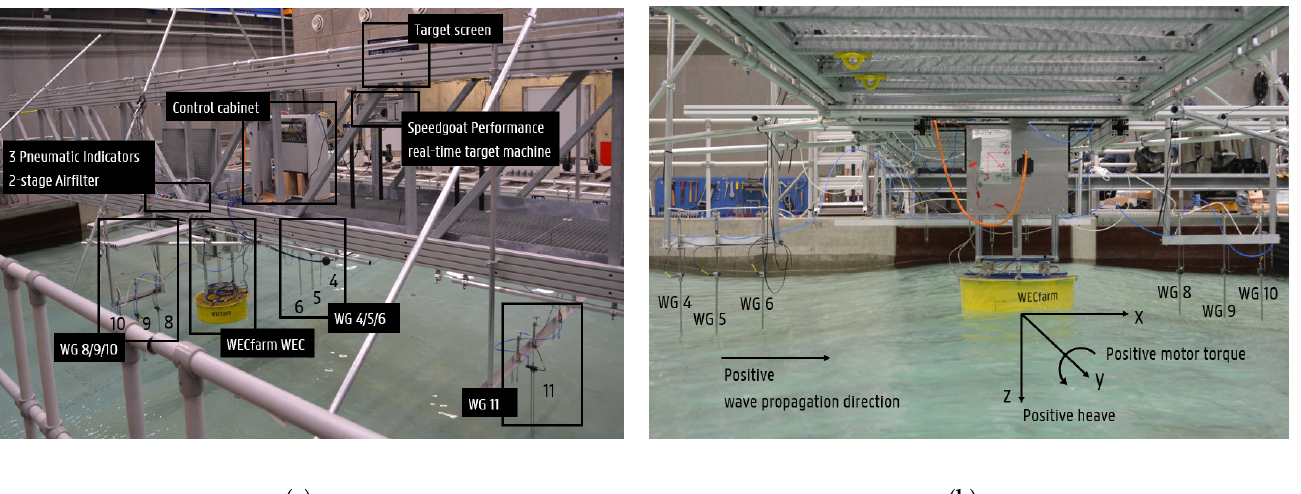
Figure 5. Experimental setup of the isolated ‘WECfarm’ WEC at the AAU wave basin: ( a ) pic- ture with indication of the subsystems; ( b ) picture with indication of the coordinate system and sign